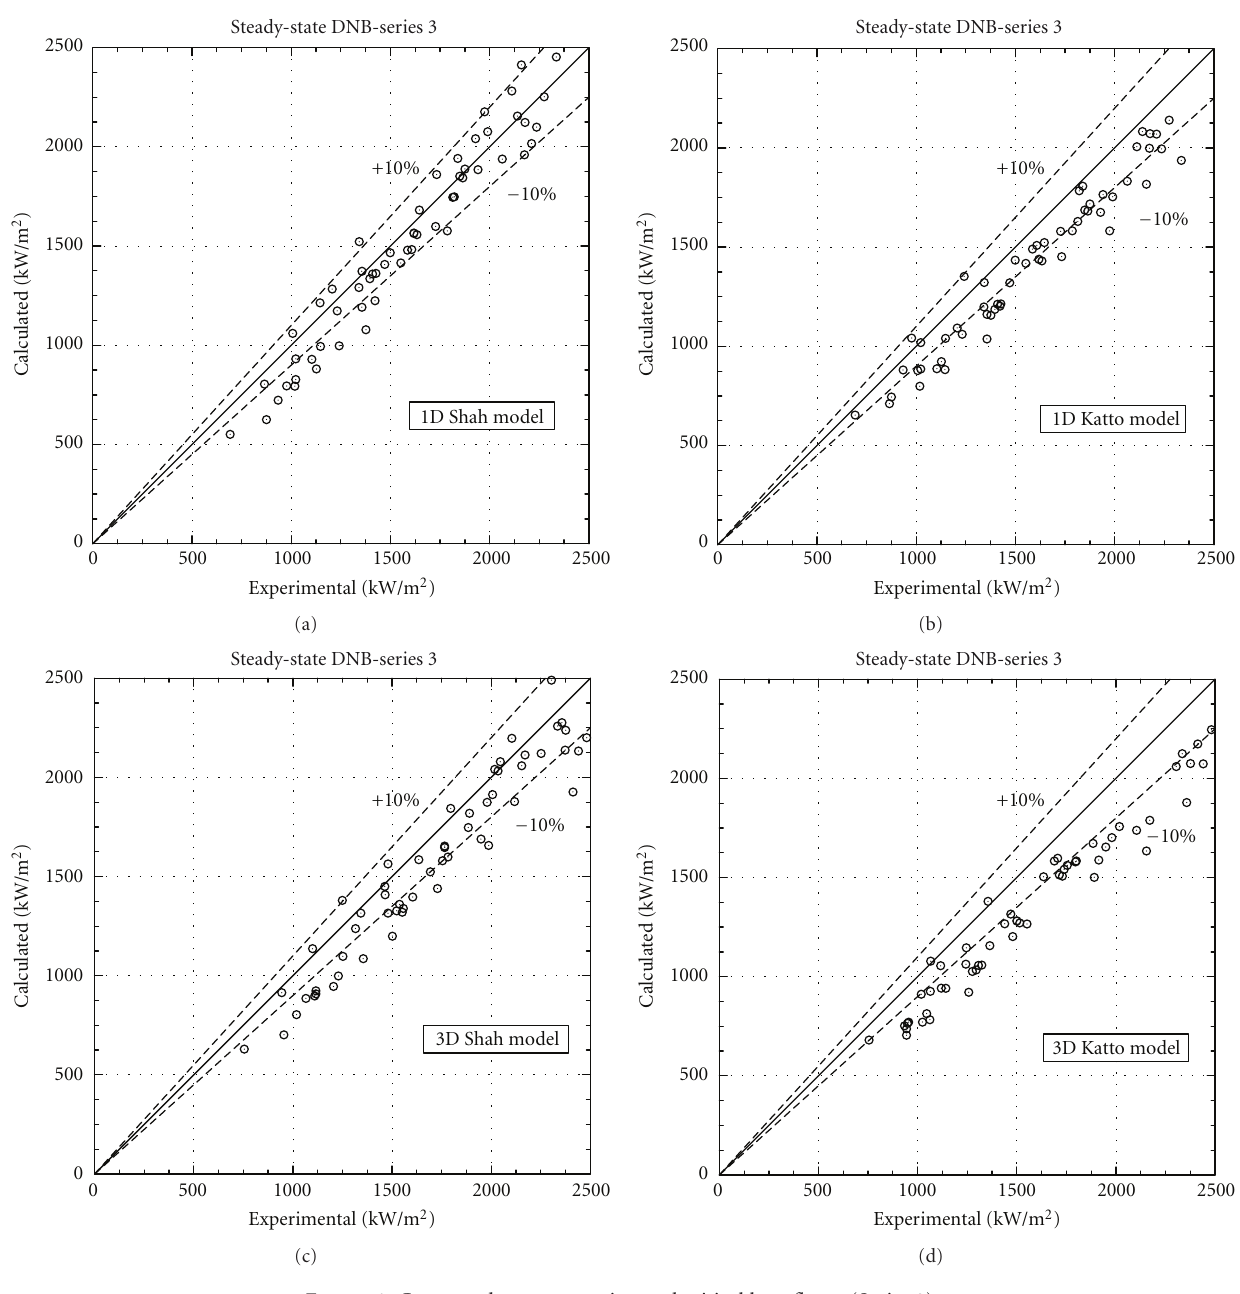
Figure 9: Computed versus experimental critical heat fluxes (Series